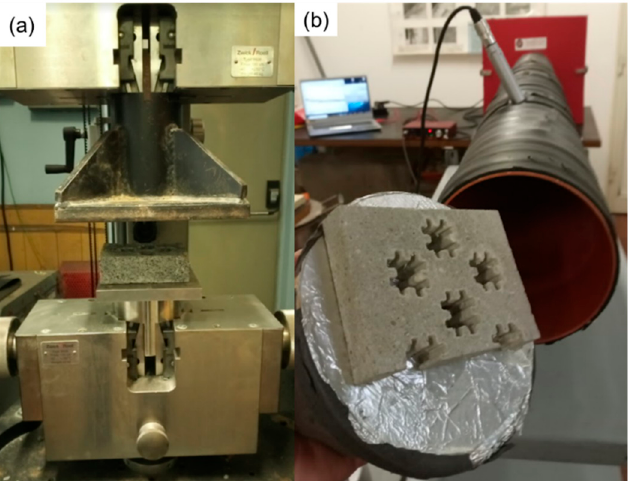
Figure 13. Experimental configurations for hollow brick characterization: ( a ) compressive test and ( b ) sound-absorption test. ( b ) sound-absorption